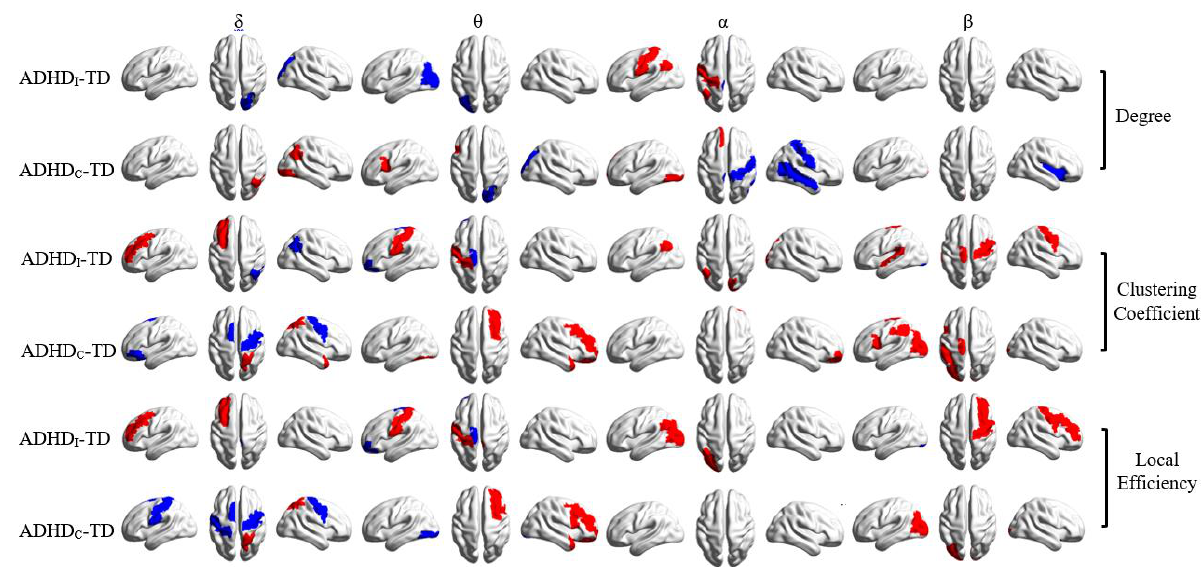
Figure 9. Statistical t-maps of significant differences ( p < 0.05) in the nodal degree, nodal clustering coefficient and local efficiency between the ADHD and TD groups. Blue and red colors show significant increases and decreases in local graph metrics (degree, clustering coefficient and local efficiency) in ADHD I or ADHD C compared to TD, respectively.